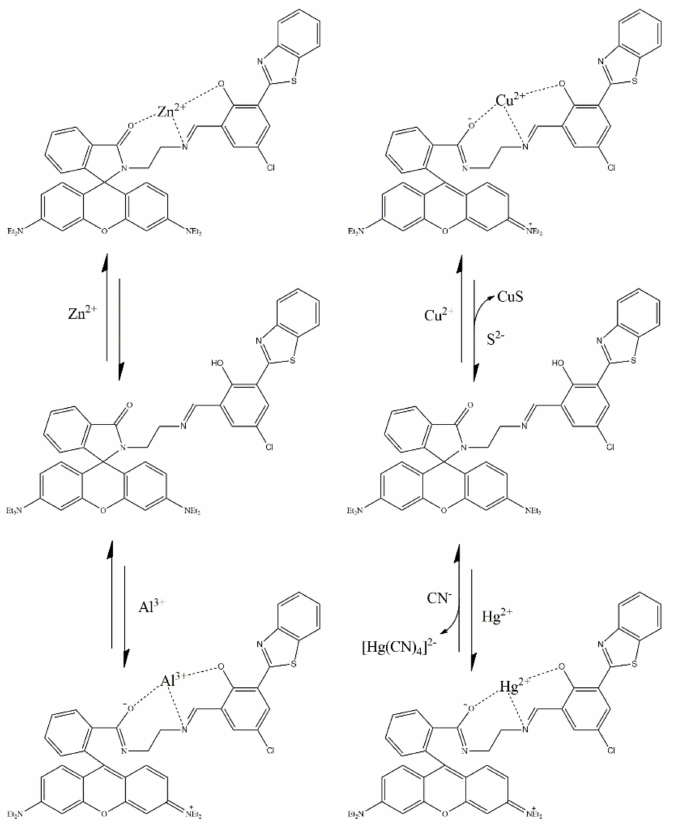
Figure 65. The proposed mechanism of coordination between the prepared sensor (Table 4, No. 20) and the target ions